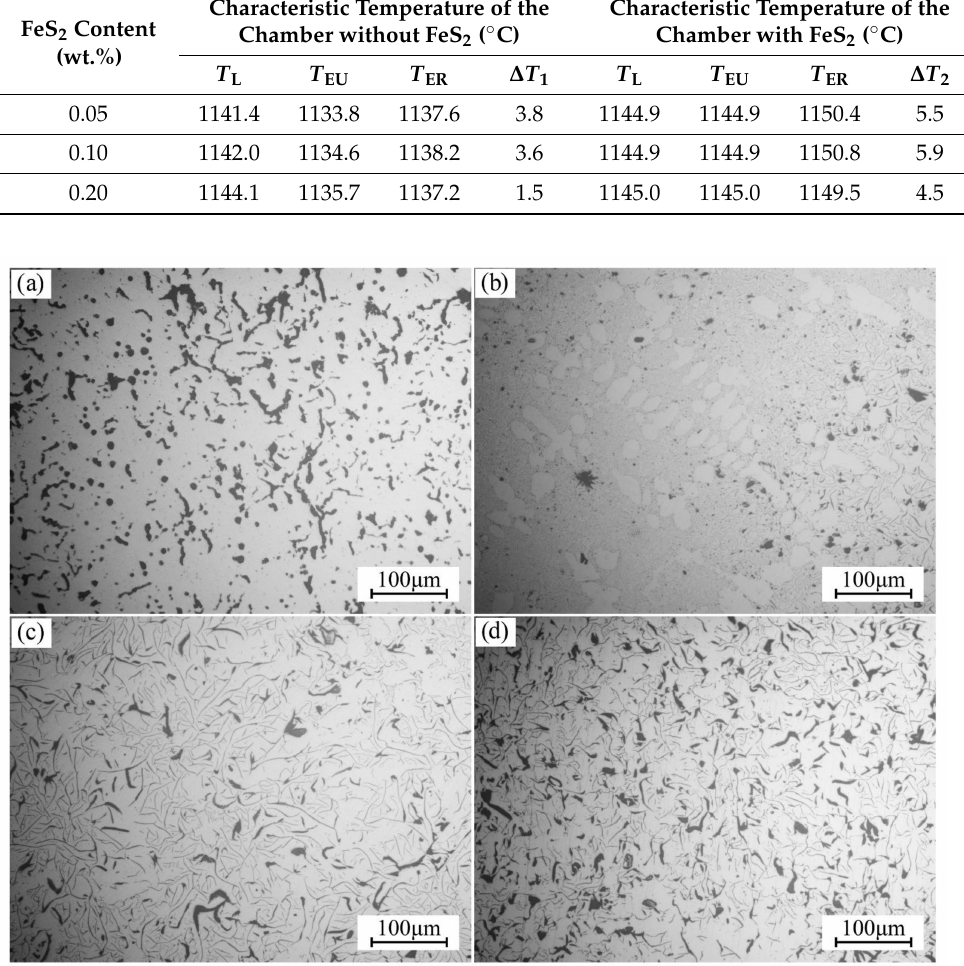
Figure 5. Graphite morphology at the central area of thermal analysis sample when FeS 2 additive was used: ( a ) 0% FeS 2 , ( b ) 0.05% FeS 2 , ( c ) 0.10% FeS 2 , ( d ) 0.20% FeS 2